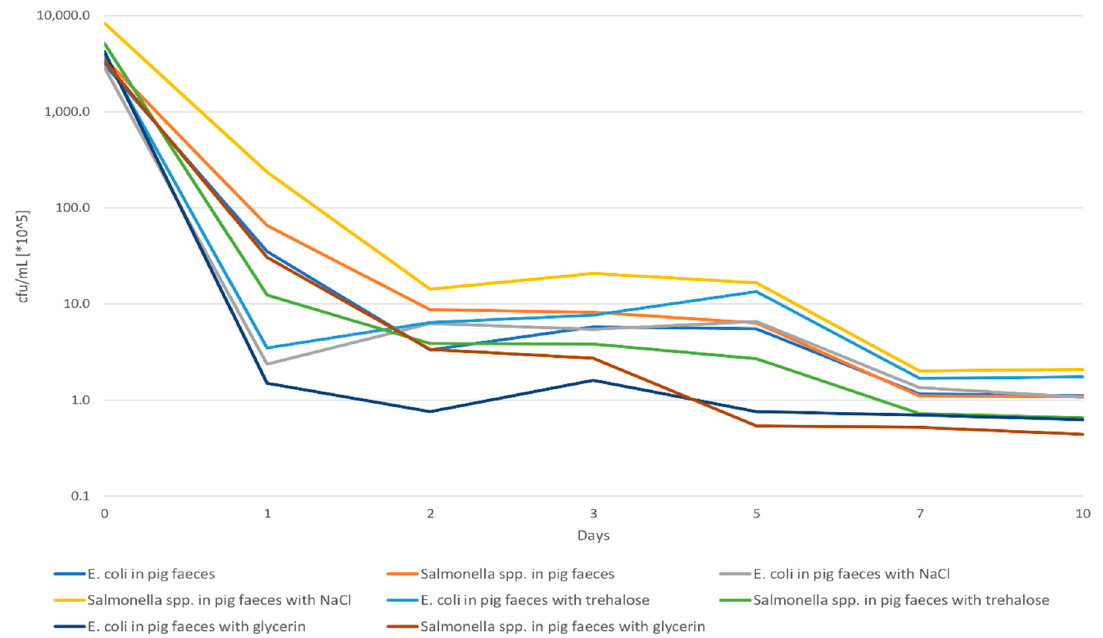
Figure 3. The decreasing number of CPE ( E. coli and Salmonella each in average) in pig faeces with and without some additives over ten days.